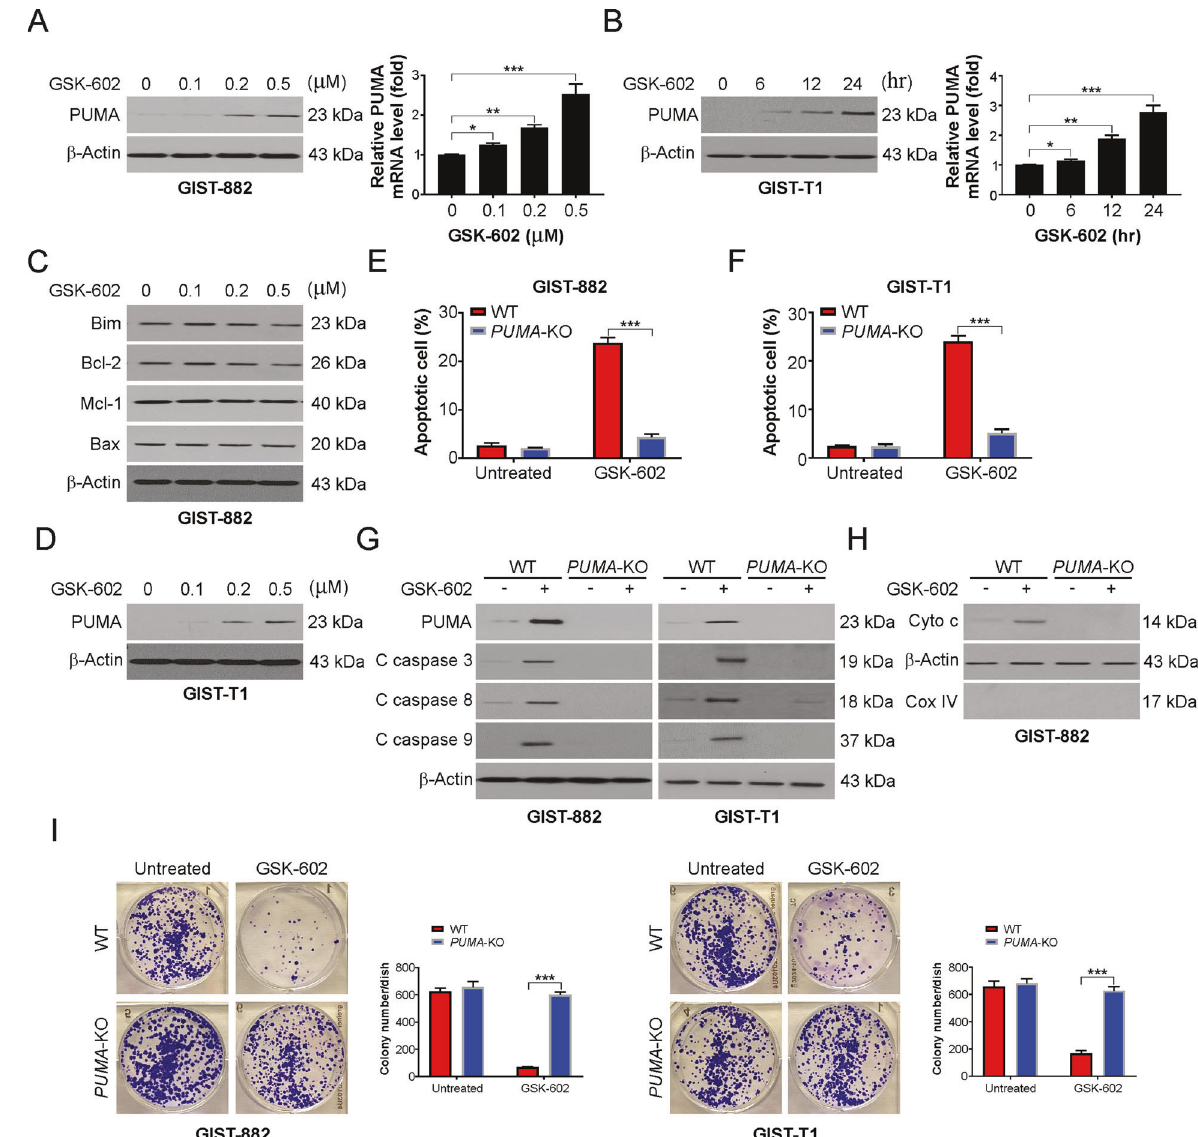
Fig. 3 PUMA is required for BRD9 inhibition-induced apoptosis in GIST. A GIST-882 cells were treated with GSK602 at indicated concentrations for 24 h. Left , PUMA expression was analyzed by western blotting. Right , PUMA mRNA level was analyzed by real-time PCR. B GIST-T1 cells were treated with GSK602 at indicated concentrations for 24 h. Left , PUMA expression was analyzed by western blotting. Right , PUMA mRNA level was analyzed by real-time PCR. C GIST-882 cells were treated with GSK602 at indicated concentrations for 24 h. The expression of indicated Bcl-2 family members was analyzed by western blotting. D GIST-T1 cells were treated with GSK602 at indicated concentrations for 24 h. The expression of PUMA was analyzed by western blotting. E WT and PUMA -KO GIST-882 cells were treated with 0.5 μ M GSK602 for 24 h. Apoptosis was analyzed by fragment nuclei assay. F WT and PUMA -KO GIST-T1 cells were treated with 0.5 μ M GSK602 for 24 h. Apoptosis was analyzed by fragment nuclei assay. G WT and PUMA -KO GIST-882 or GIST-T1 cells were treated with 0.5 μ M GSK602 for 24 h. Indicated protein level was analyzed by western blotting. H Cytosolic fractions isolated from WT and PUMA -KO GIST-882 cells treated with 0.5 μ M GSK602 for 24 hr were probed for cytochrome c by western blotting. β -actin and cytochrome oxidase subunit IV (Cox IV), which are expressed in cytoplasm and mitochondria, respectively, were analyzed as the control for loading and fractionation. I WT and PUMA -KO GIST-882 or GIST-T1 cell lines were treated 0.5 μ M GSK602 for 24 h. Cell viability was analyzed by colony formation assay. Results were expressed as means ± SD of three independent experiments. * P < 0.05; ** P < 0.01; *** P <